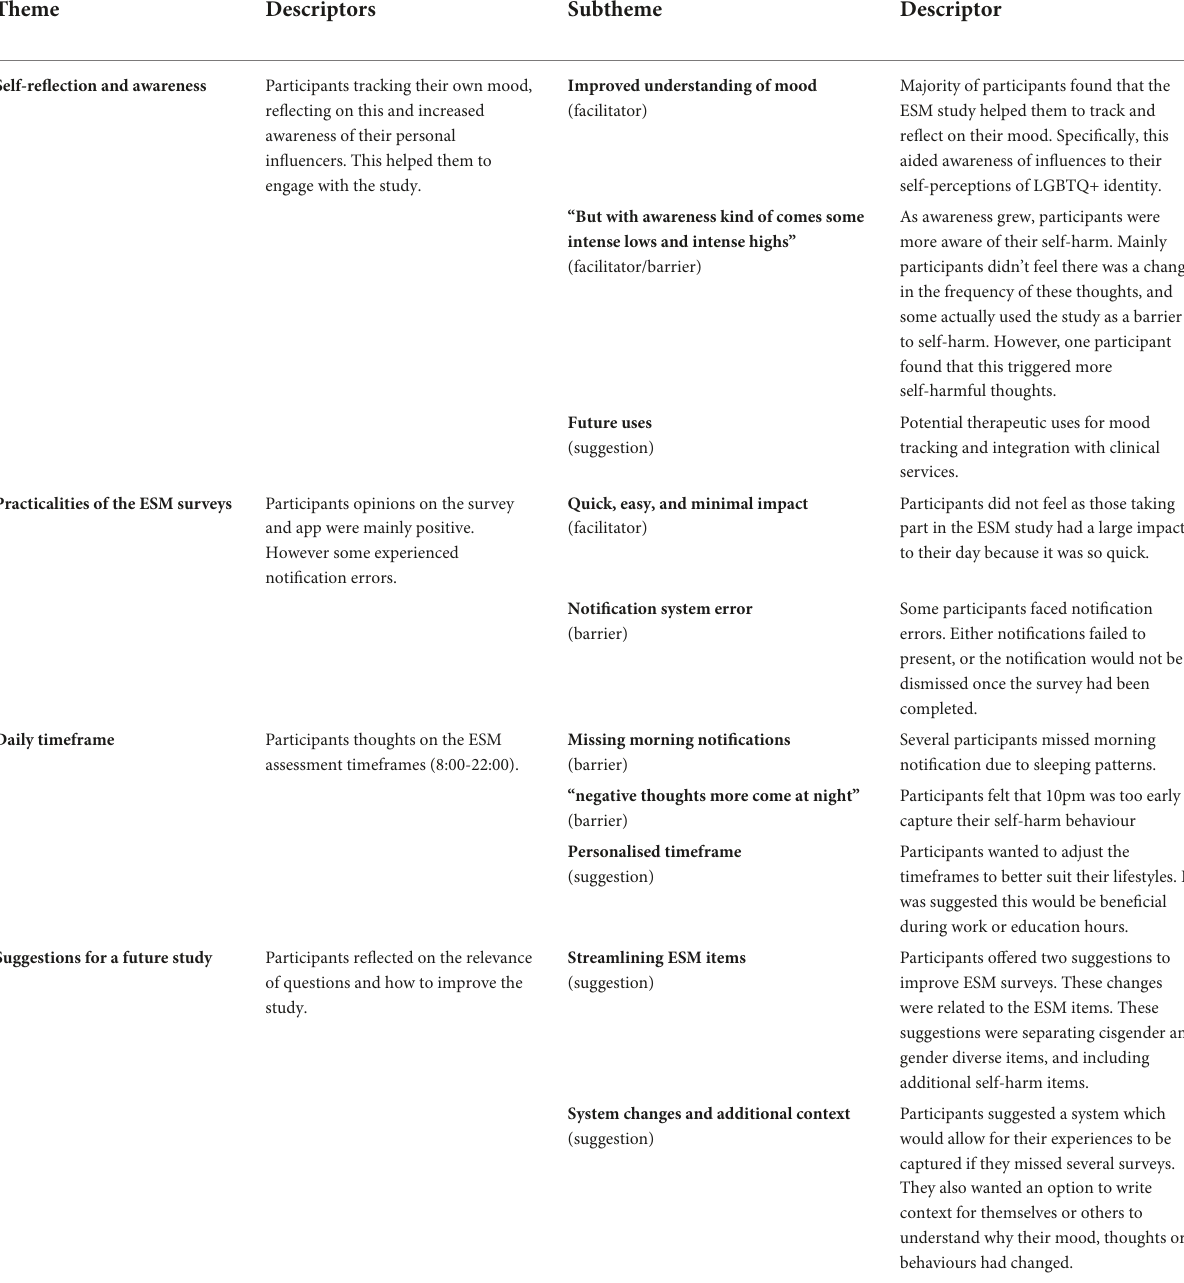
TABLE 5 Thematic framework of barriers and facilitators of taking part in the experience sampling method (ESM)